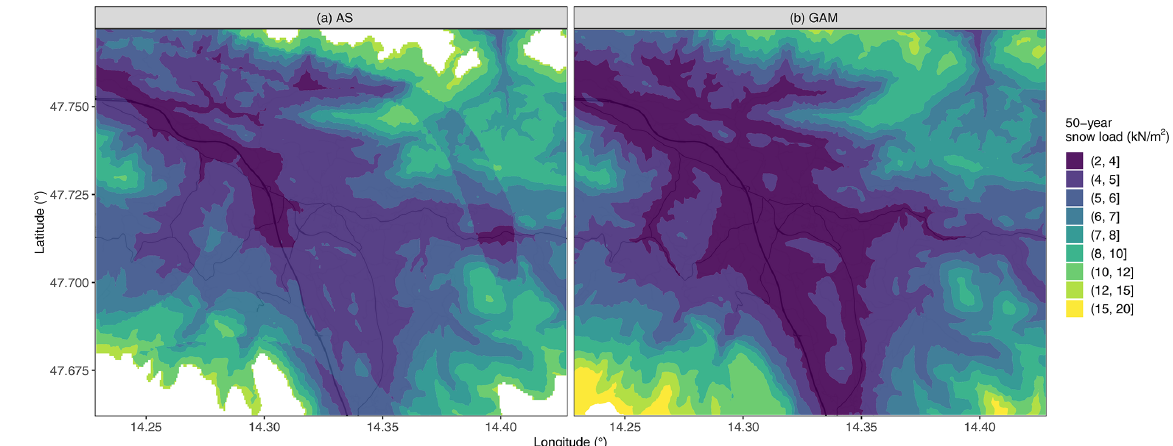
Figure 5. Values of 50-year snow load return for a region around Windischgarsten in the center of Austria, taken from the map of the current Austrian snow load standard ( a , AS; valid up to 1500m) and the newly proposed GAM approach ( b , plotted up to 2000m). Pixel size is 50m by 50m. Main roads are depicted in the background for easier